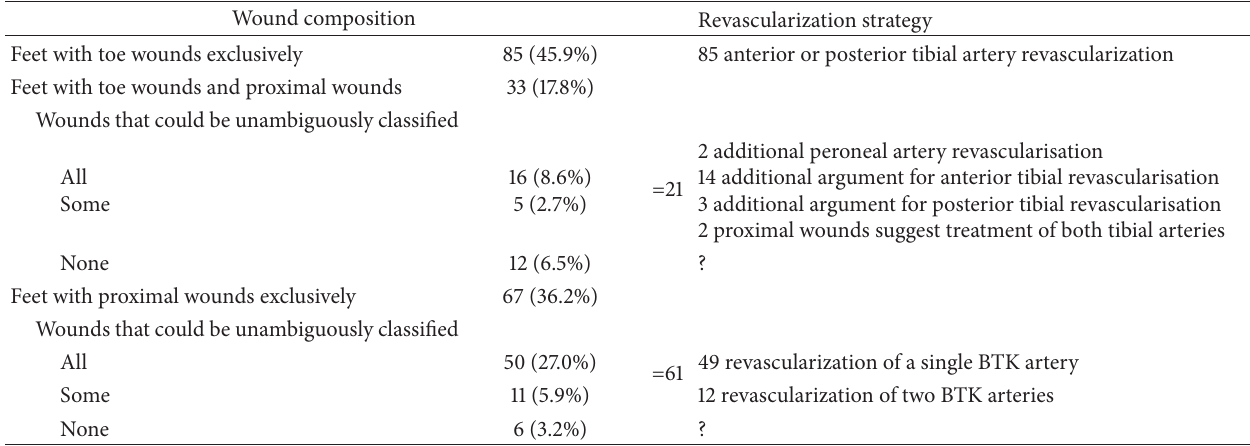
Table 3: Wound composition in diabetic feet ( 𝑛 = 185